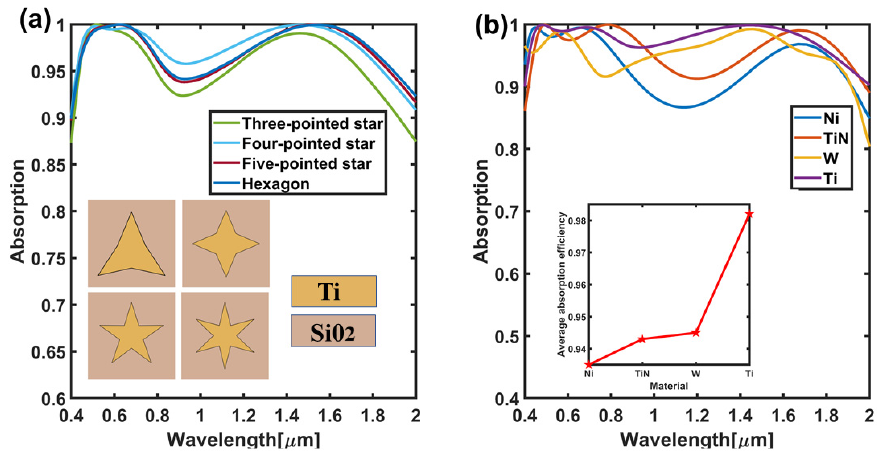
Figure 8. Polyhedron and different absorption efficiency of materials. ( a ) The absorption efficiency diagrams for different polygonal stars; ( b ) The absorption efficiency diagram of the four-pointed star with different materials.